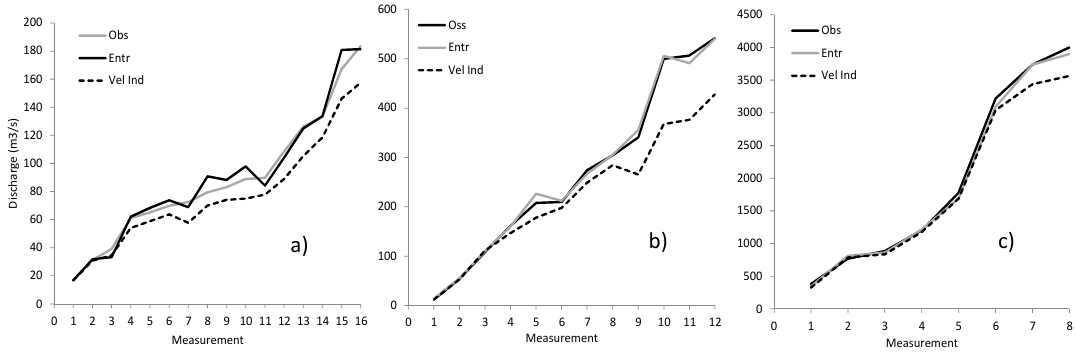
Figure 7. Comparison between observed discharge (Obs) and discharge computed by the Entropy approach (Entr) and the velocity index (Vel Ind) for ( a ) Santa Lucia, ( b ) Ponte Nuovo, and ( c ) Pontelagoscuro.